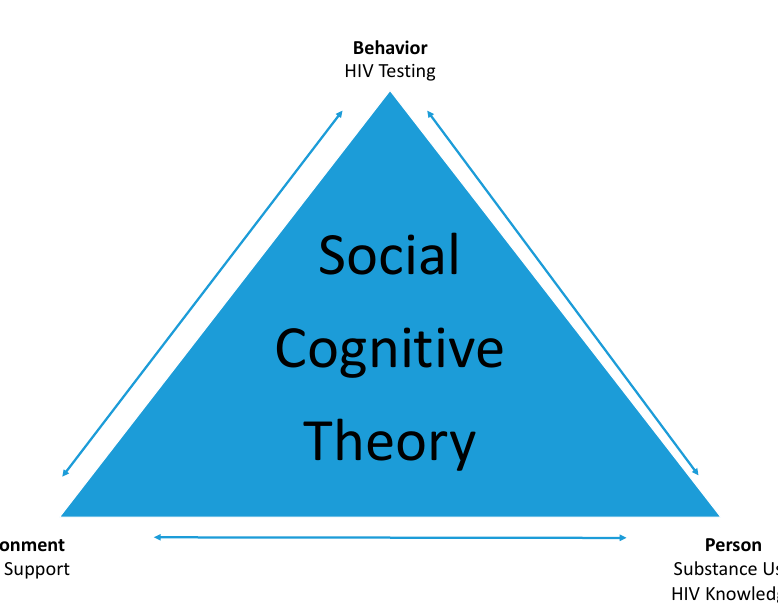
Figure 1. Social Cognitive Theory (SCT) Applied to HIV Testing.